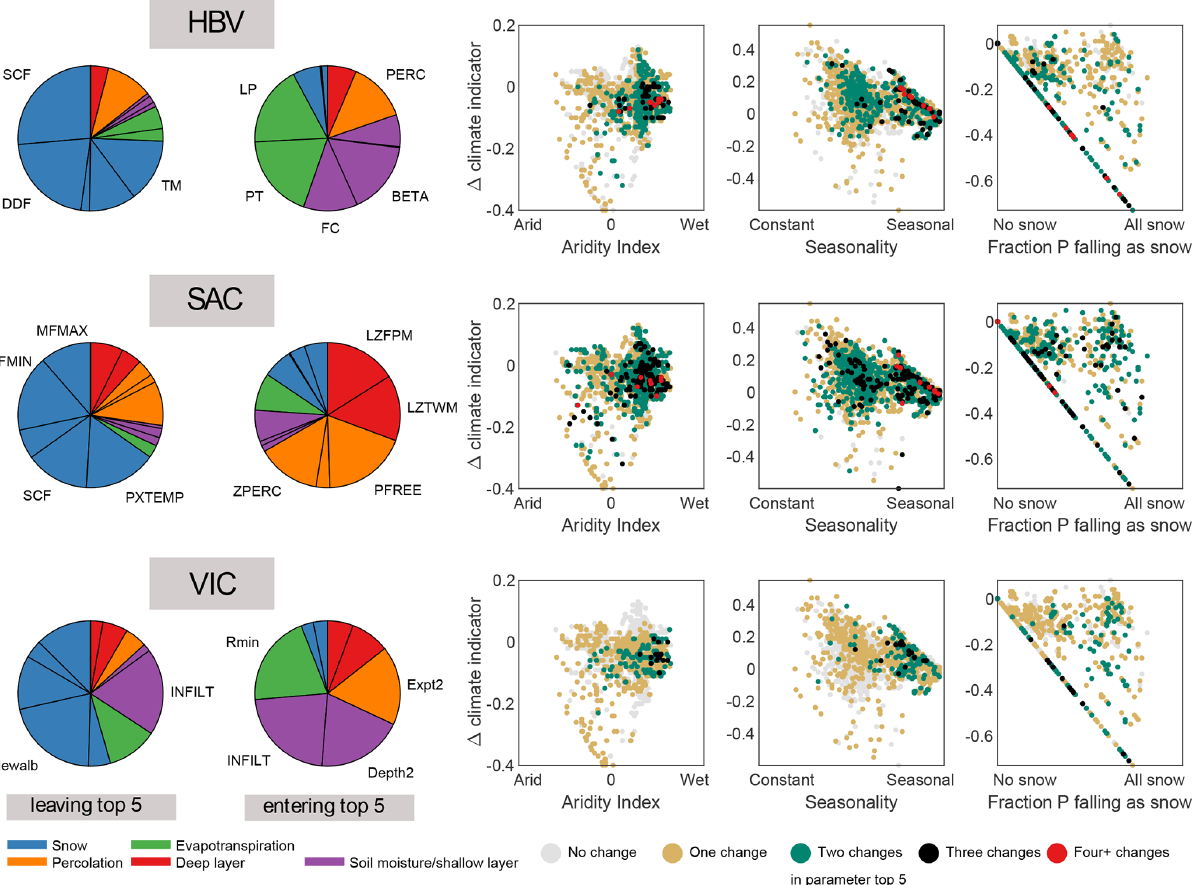
Figure C4. Impact of change in parameter sensitivity to top-5 position for the discharge timing, where top-5 refers to the five most sensitive parameters per basin – generally the parameters that are calibrated. The pie charts show which parameters leave the top-5 (left) and which parameters enter the top-5 (right). The right panels relate the number of changes in the parameter top-5 to climate and climate change